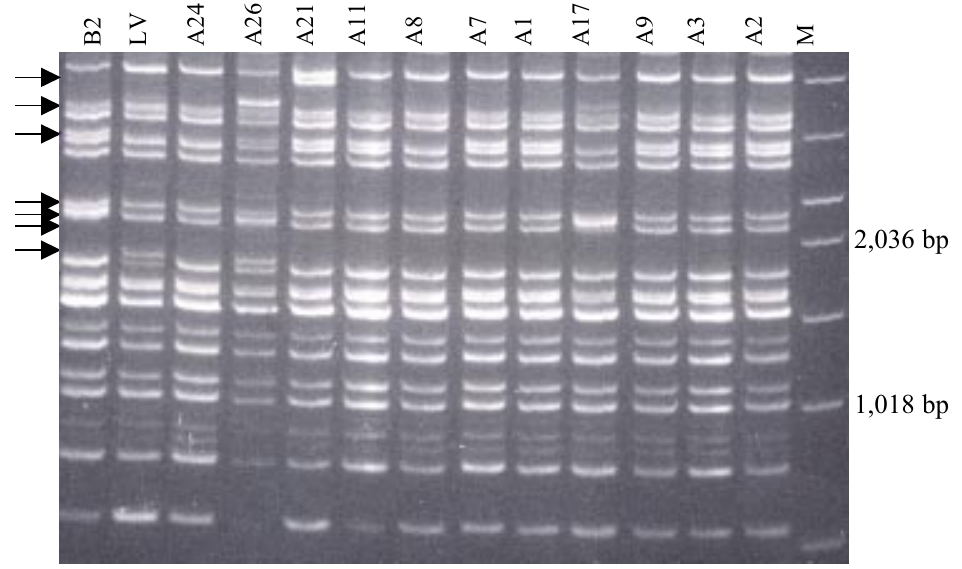
Fig. 3. Banding patterns of Phaeomoniella chlamydospora isolates generated by AFLP primer pair GA/CAT and separated by 1% agarose gel electrophoresis. M designates the 1 kb DNA ladder; size is shown on the right of the gel. Arrows indicate polymorphic